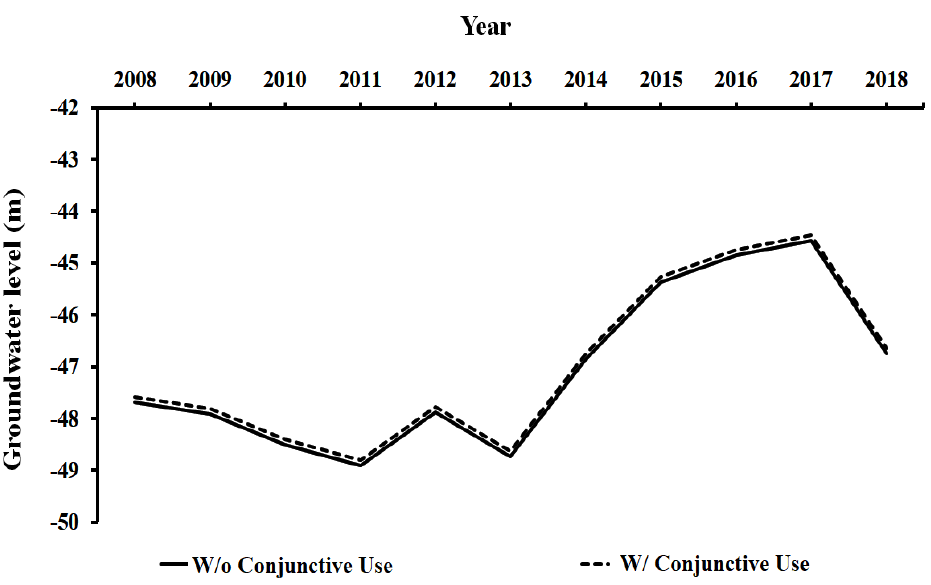
Figure 10. Change in the groundwater level with and without conjunctive use in the Osan subarea.